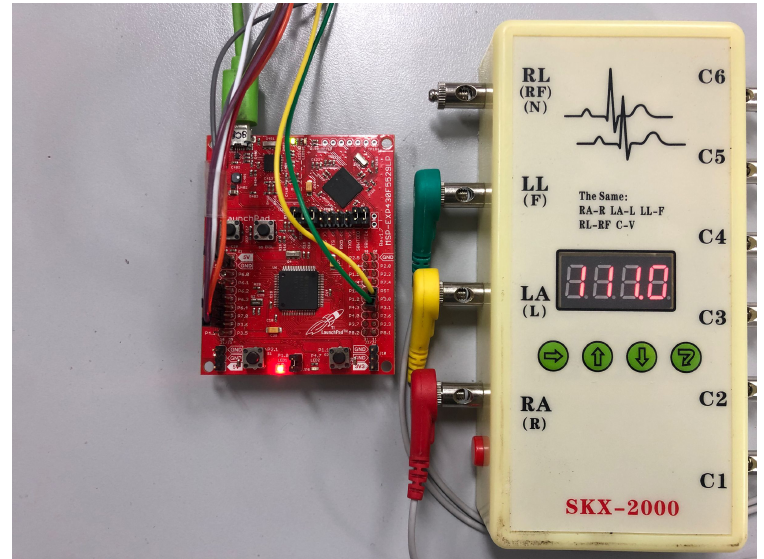
Figure 9. The output heart rate of the ECG simulator is 110 BPM, which simulates the condition of a high heart rate, and the system LED lights up as an